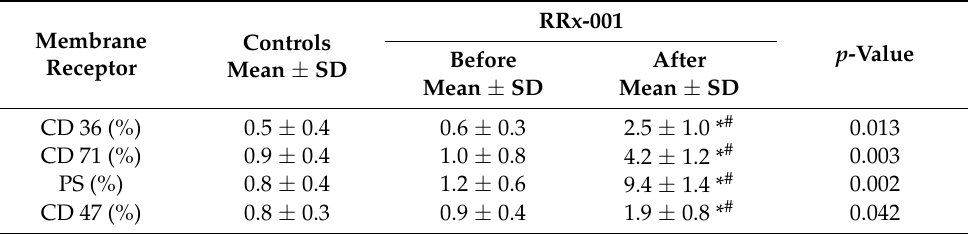
Table 1. Changes in Erythrocyte Receptor Expression after RRx-001 Treatment. * p < 0.05 relative to controls. # p < 0.05 (paired t -test) relative to pre-treatment